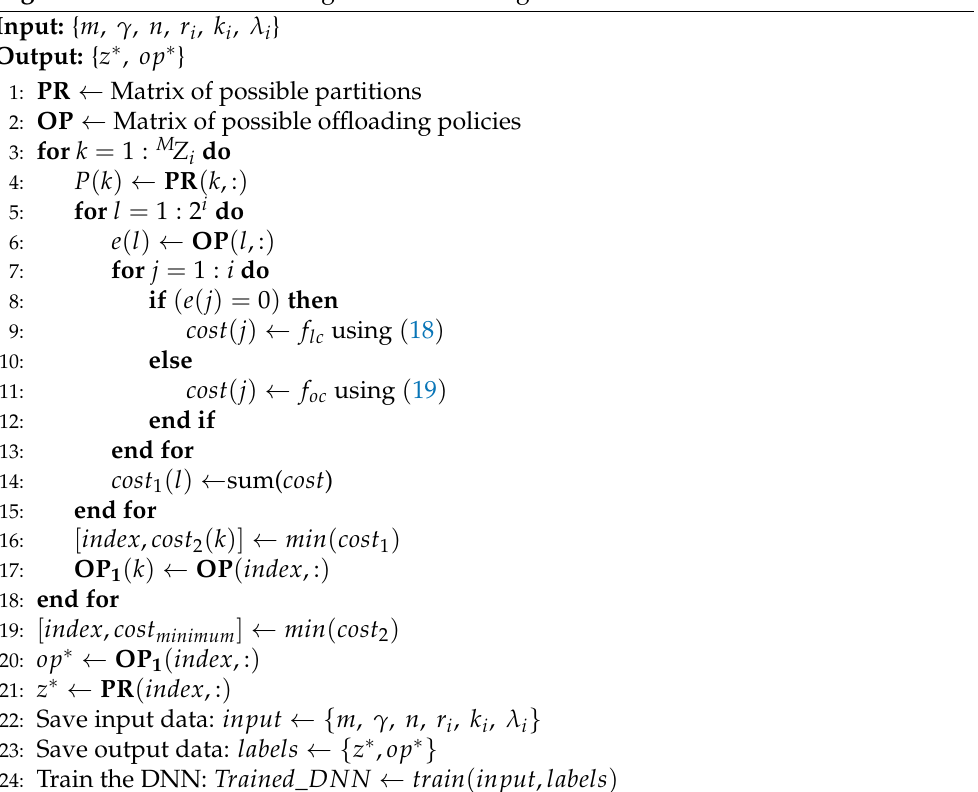
Algorithm 1 Partial Offloading with Partitioning